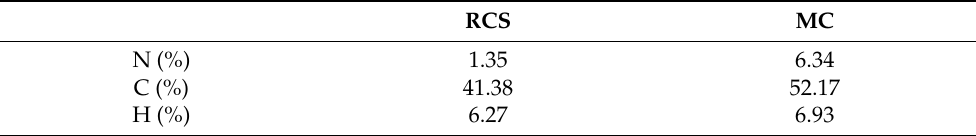
Table 3. Elemental content of raw cornstalk (RCS) and modified corn (MC)